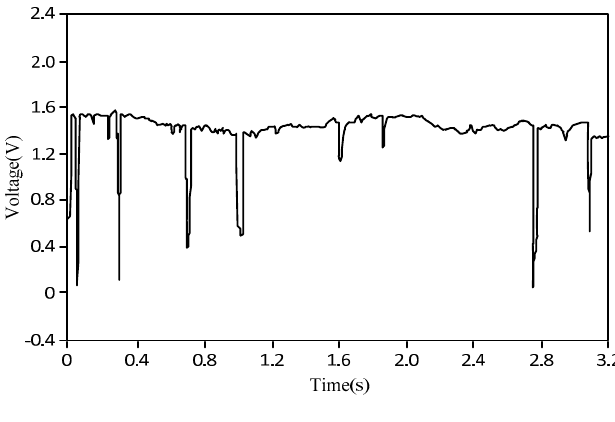
Figure 7. Graph of bubble flow.